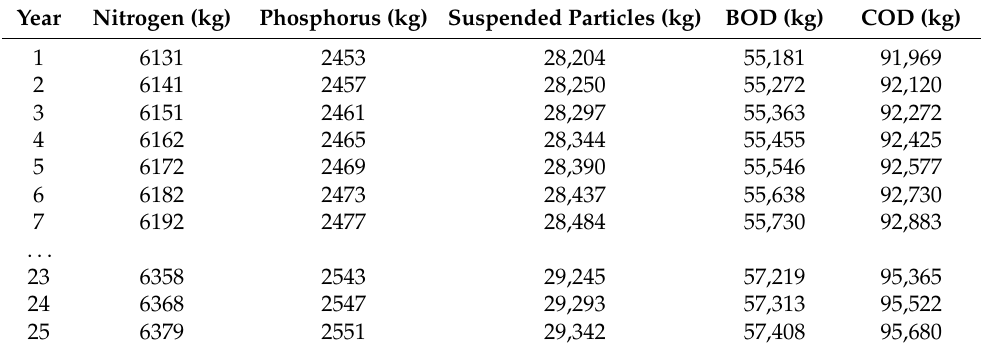
Table 11. Projection of reduction in pollutants after treatment in